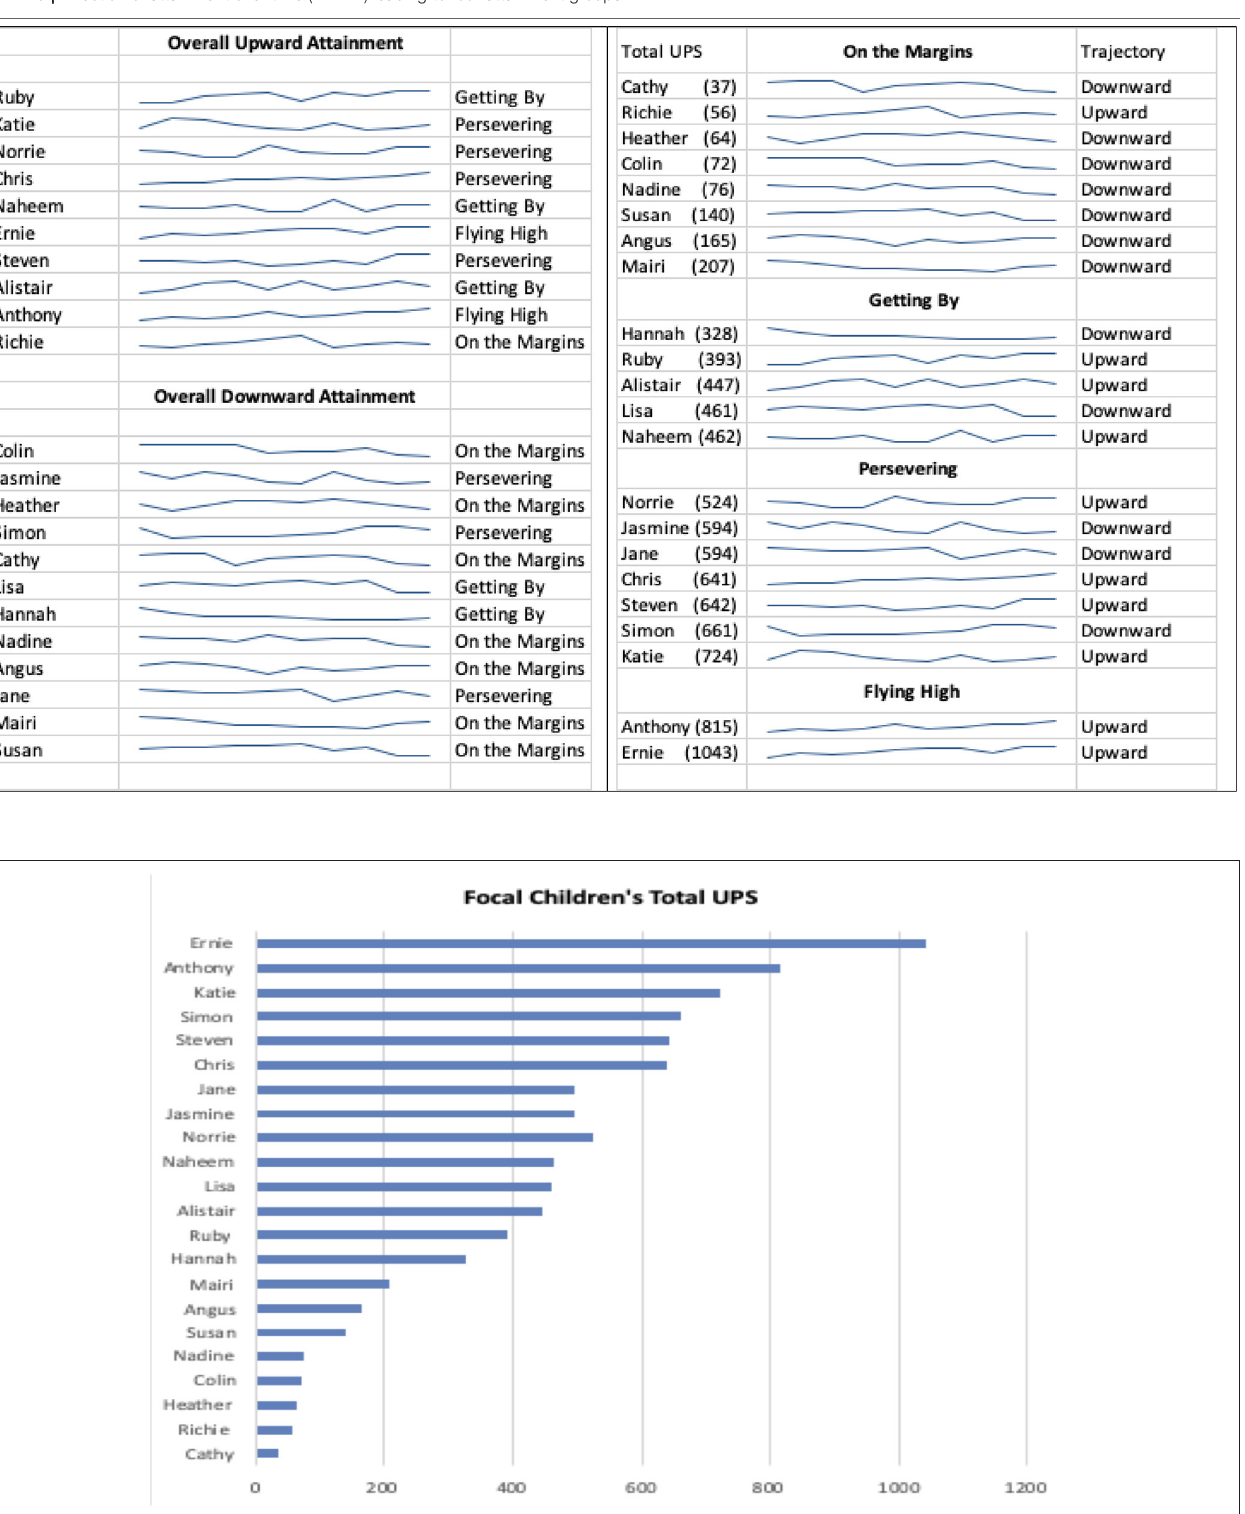
FIGURE 2 | Focal children’s SQA national assessment in S4, S5, and S6 showing total scores accumulated in English and Maths and in all other subjects taken.